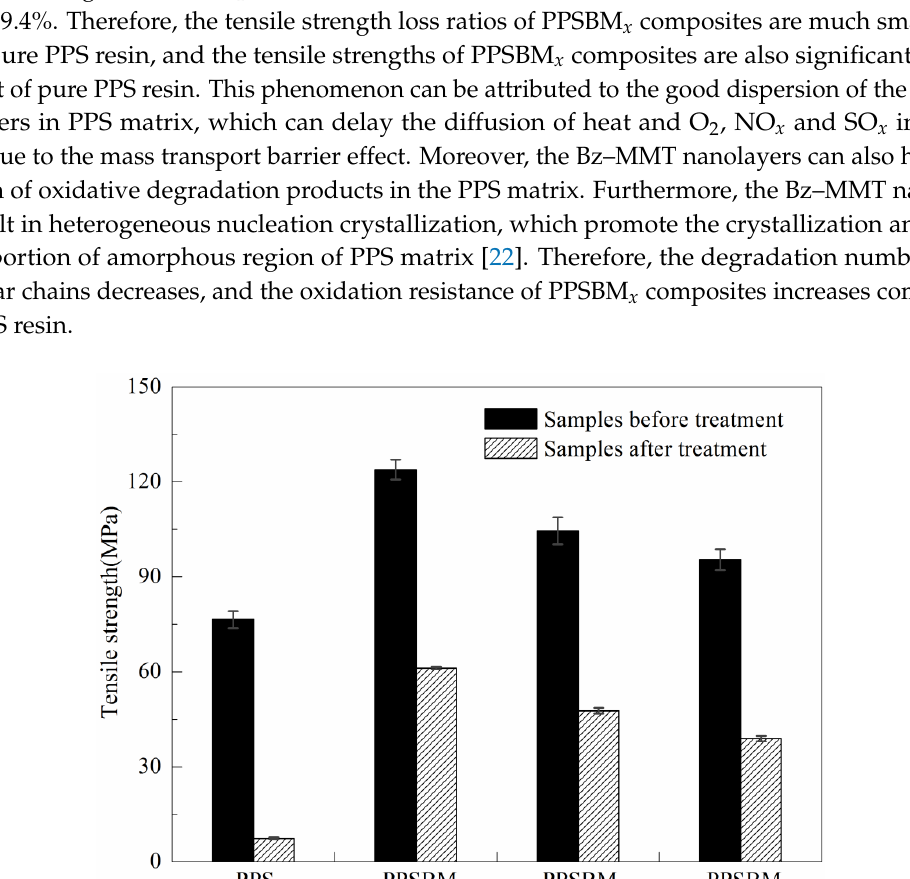
x composites after oxidation